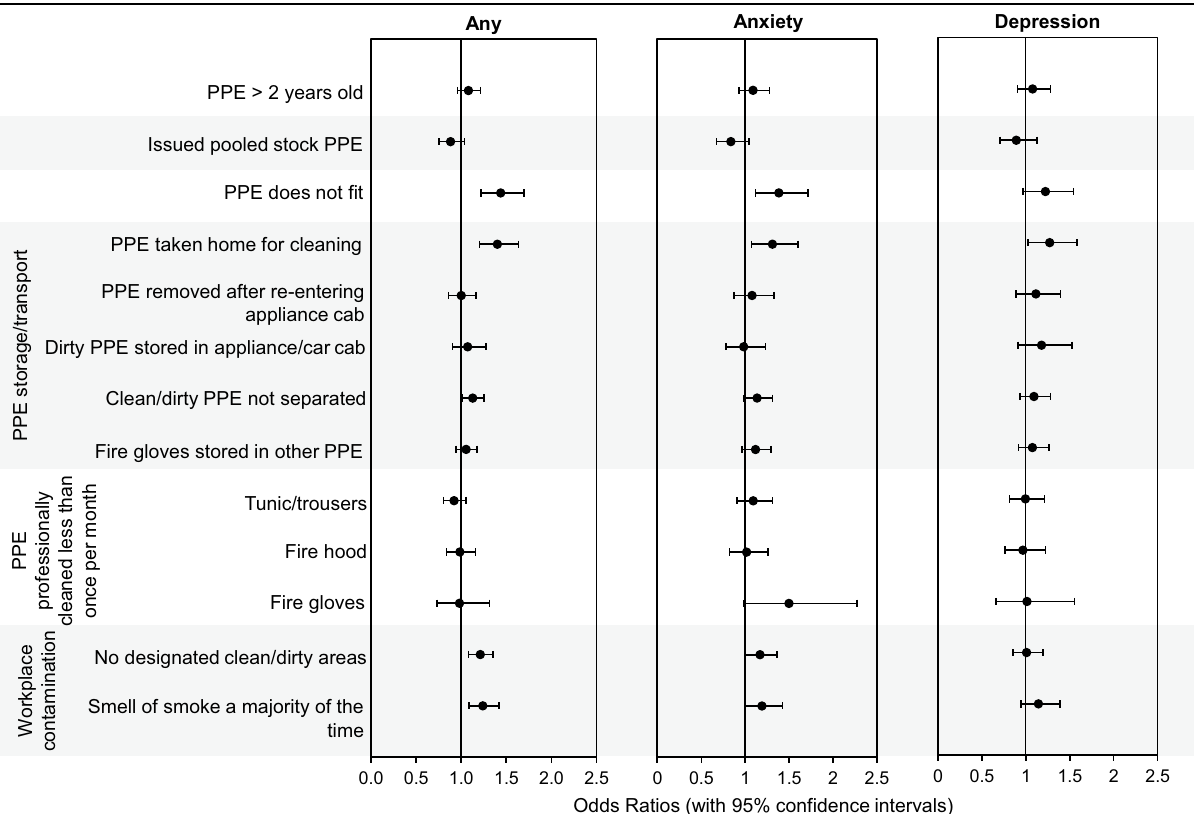
Odds Ratios (with 95% confidence intervals) Figure 6. Firefighters’ PPE/Workplace Contamination and Mental Health Odds Ratios. Odds ratios (with 95% confidence intervals) were adjusted for various mental health risk factors (Supplementary File